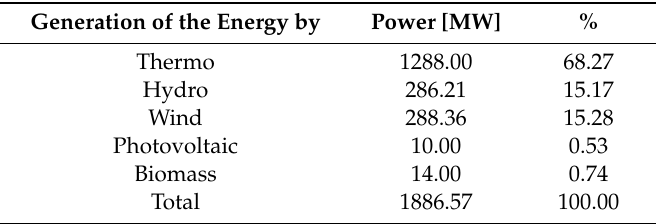
Table 11. Electric installed and planned capacity potential in